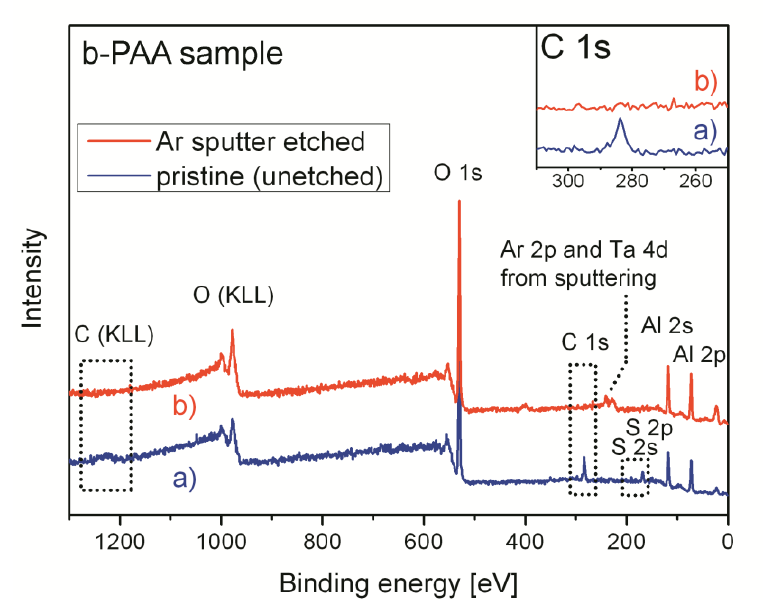
Figure 8. Al K α (h ν =1486.7 eV) survey photoelectron spectra of a b-PAA sample before [blue color, ( a )] and after [red color, ( b )] Ar + ion etching. All detected elements are inherent to the typical “sulfuric” anodic alumina composition [see ( a )]. Casual Ta 4d signals after Ar + -ion sputtering [see ( b )] are due to the XPS-sample preparation procedure (films were pressed to the sample holder by Ta-foil with perforated 2 × 2 mm windows, see the experimental section for explanations). The C 1s photoelectron signal inset demonstrates complete absence of carbon in the bulk of the sample after removal of the thin surface layer ( ≈ 30 nm) containing adsorbed